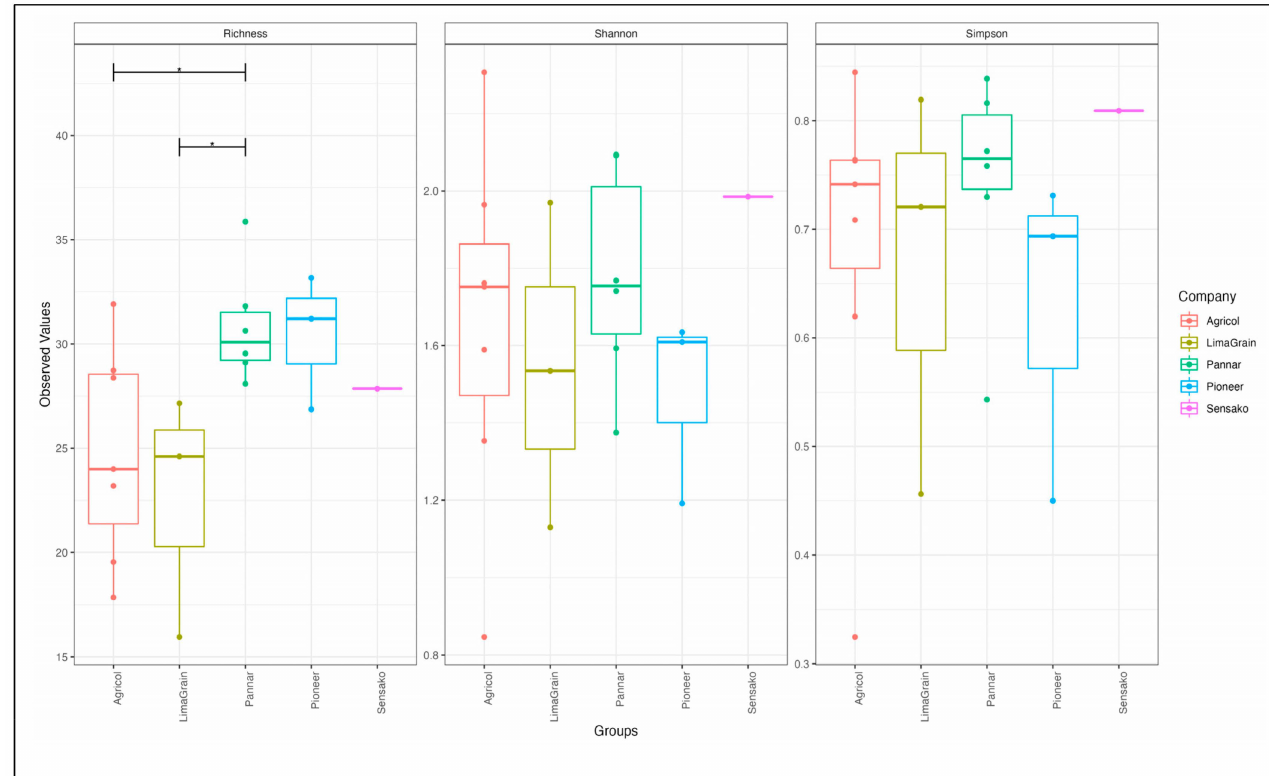
Figure 6. Fungi alpha diversity measurement for the observed number of ASVs (richness) for Chao1 ( left ), Shannon diversity ( middle ) and Simpson index ( right ) of sunflower seed